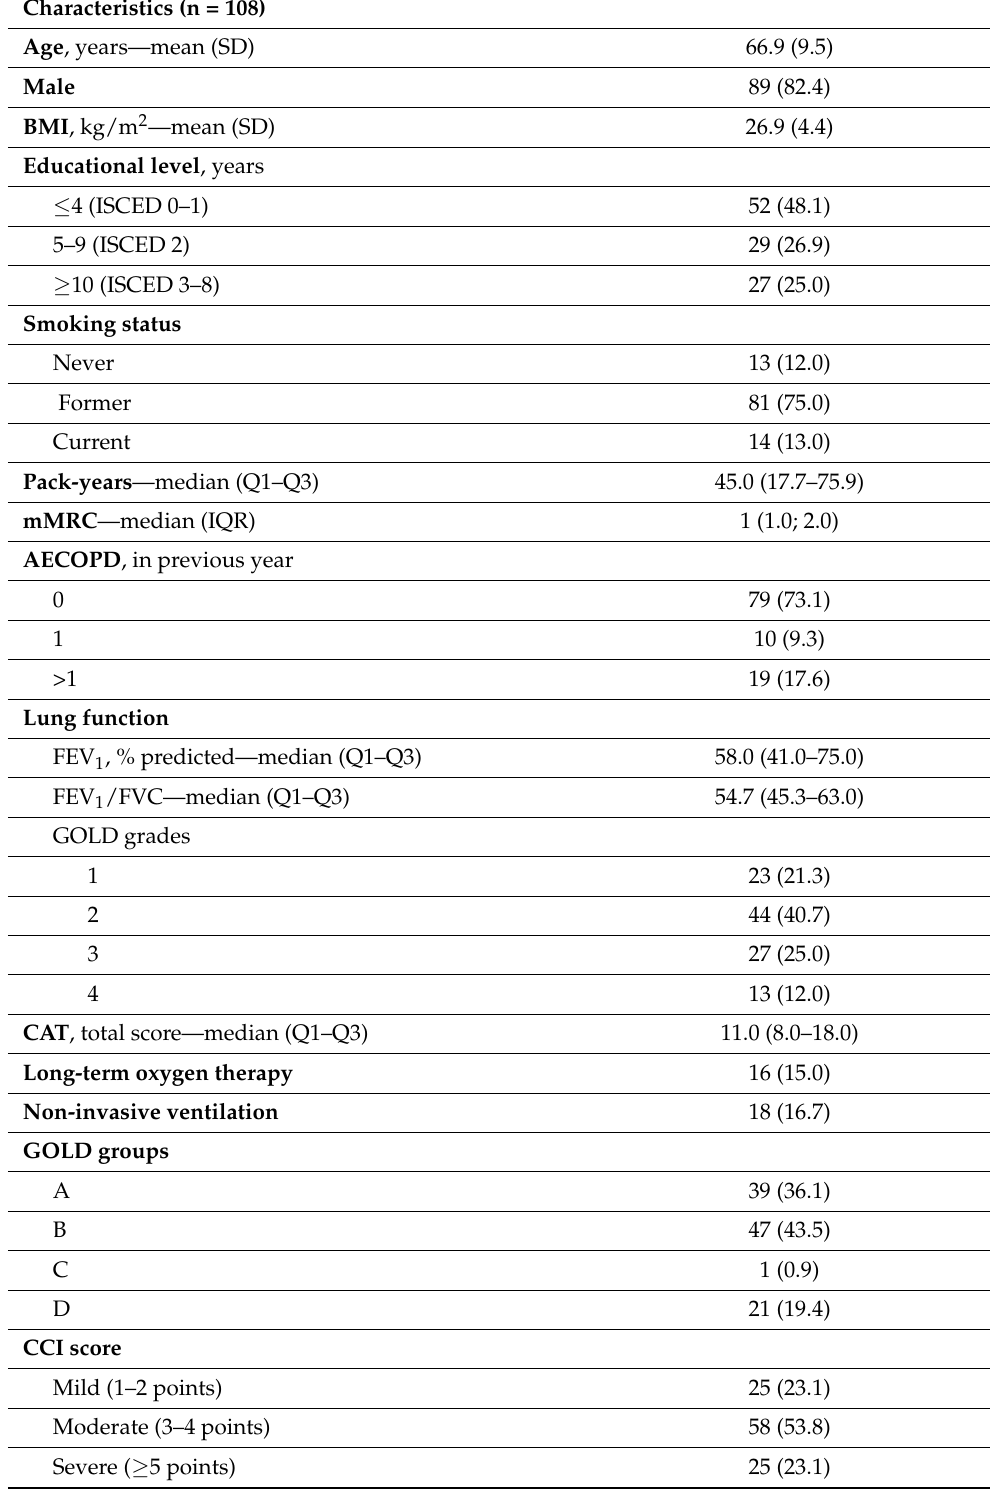
Table 1. Baseline characteristics of participants with chronic obstructive pulmonary disease (n =